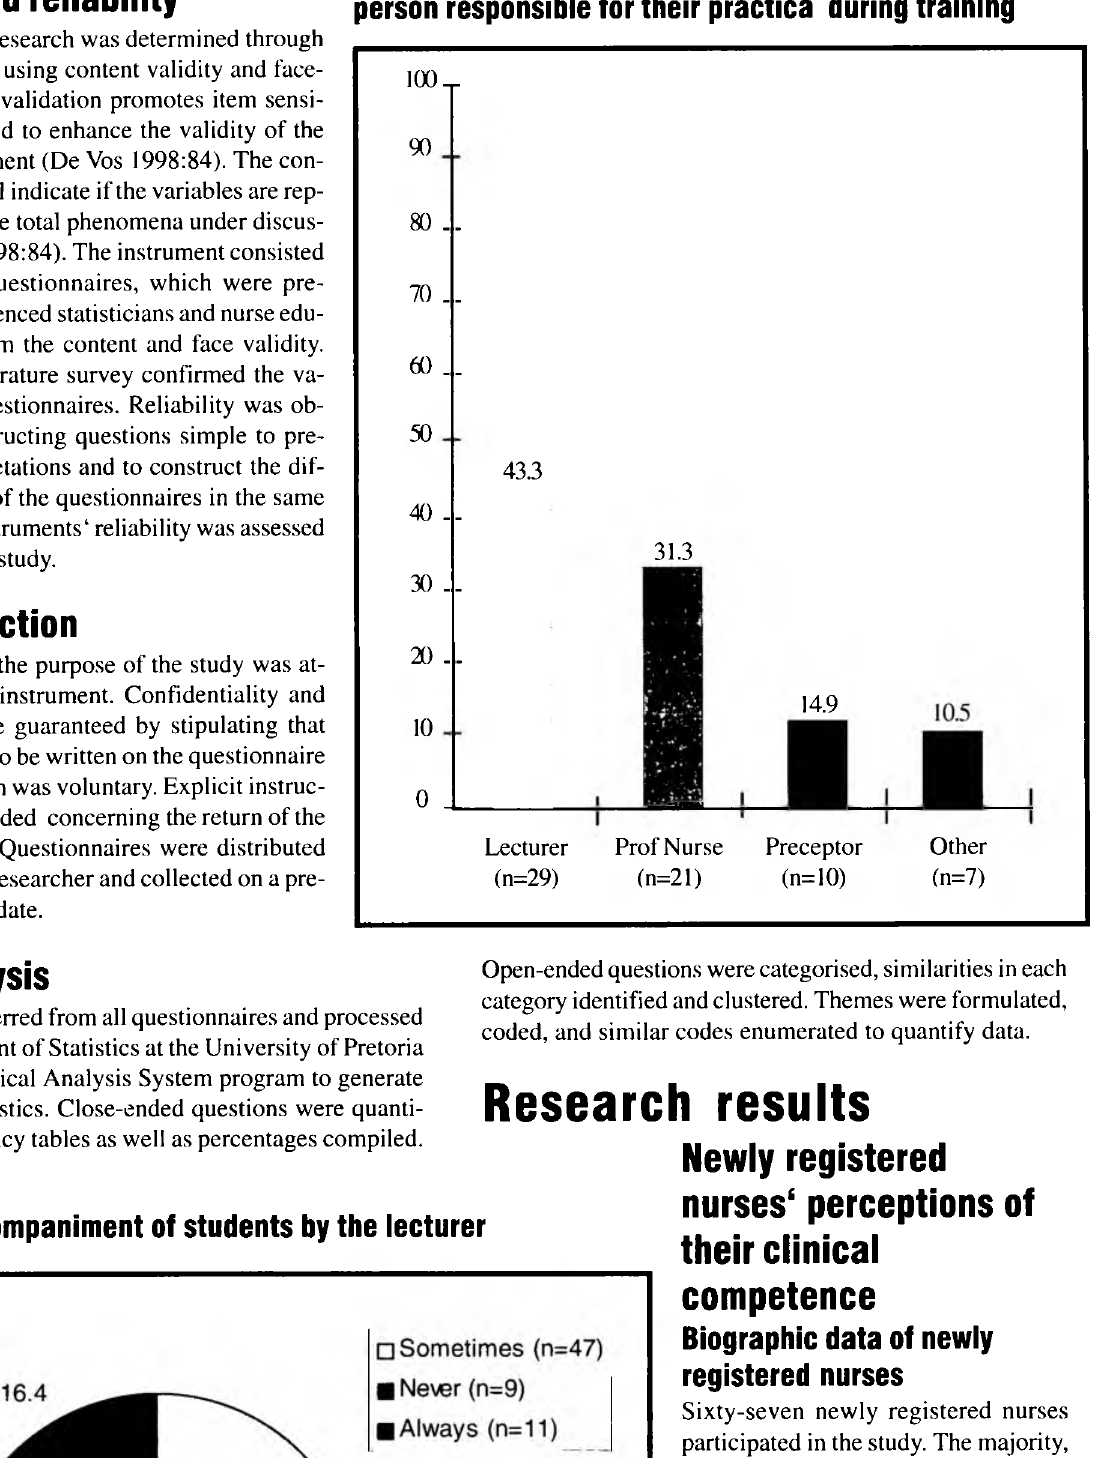
Figure 2: Newly registered nurses‘ perception of the person responsible for their practica during training